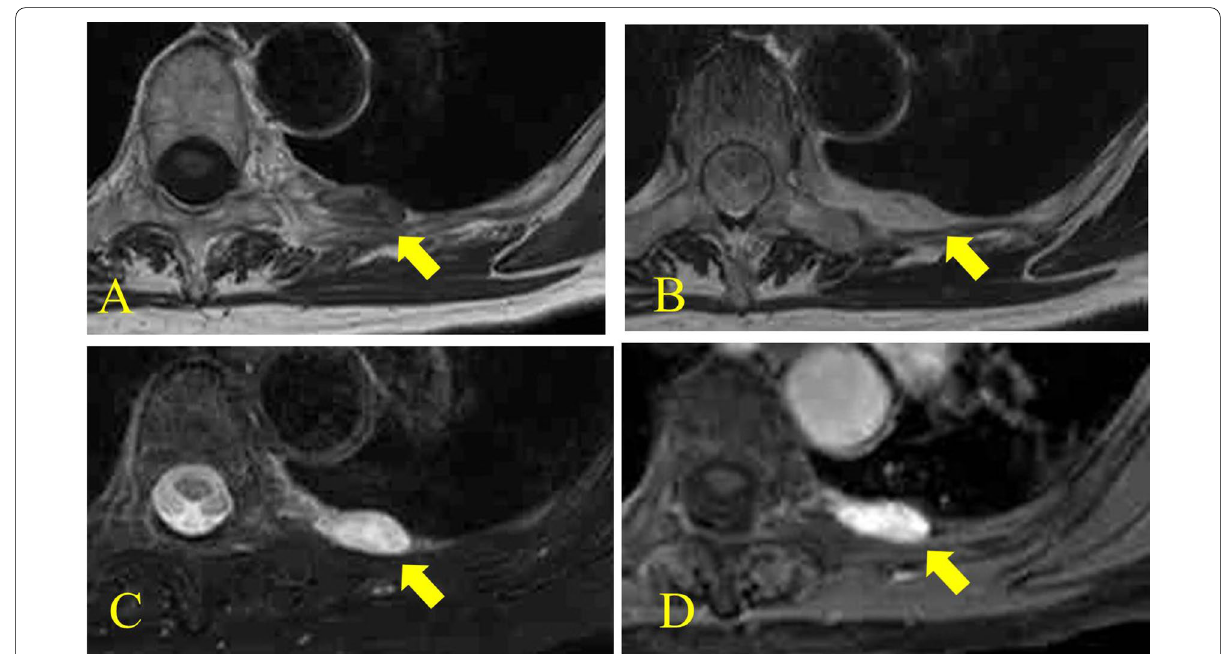
Fig. 2 Chest MRI findings. The lesion showed low signal intensity on T1-weighted images ( A ), heterogeneous high signal intensity on T2-weighted images ( B ) and high signal intensity on fat-suppressed T2-weighted images ( C ). The lesion showed heterogeneous enhanced effect on gadolinium-based contrast agent ( D